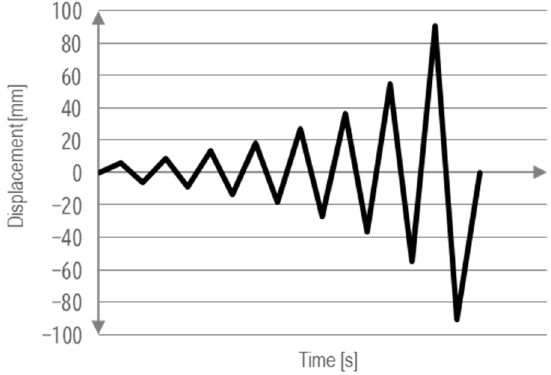
Figure 11. Test schedule of the full-scale in-plane cyclic test.